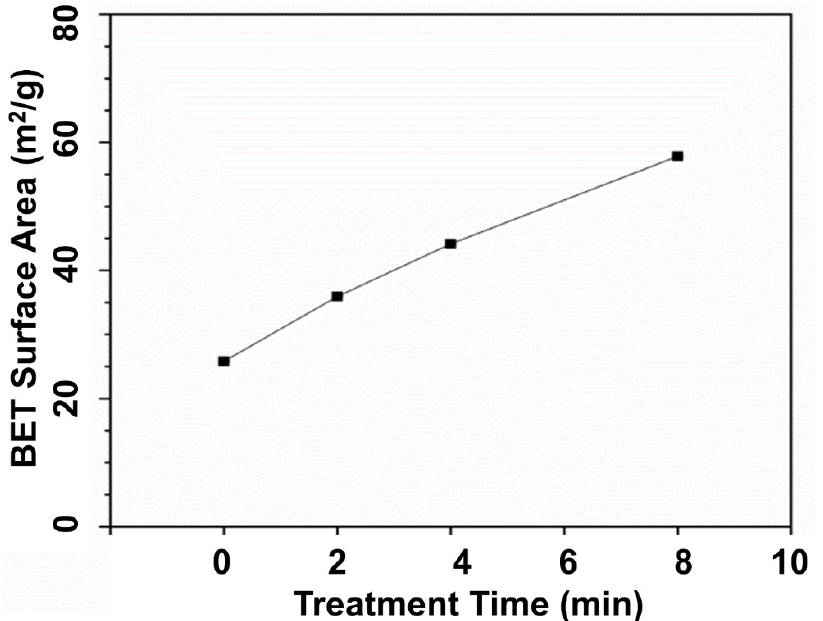
Figure 1. Specific surface area of HNT by acid treatment time.